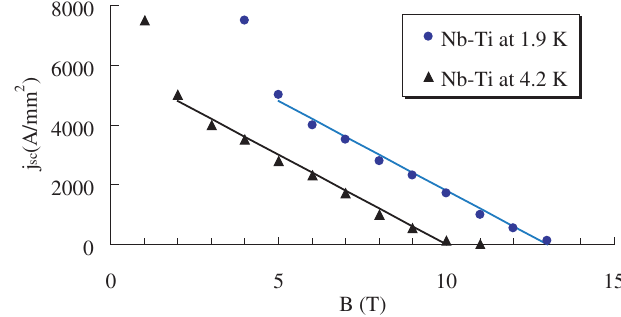
FIG. 1. (Color) Critical surface for Nb-Ti at 1.9 K and at 4.2 K, and linear fit given in Eq.